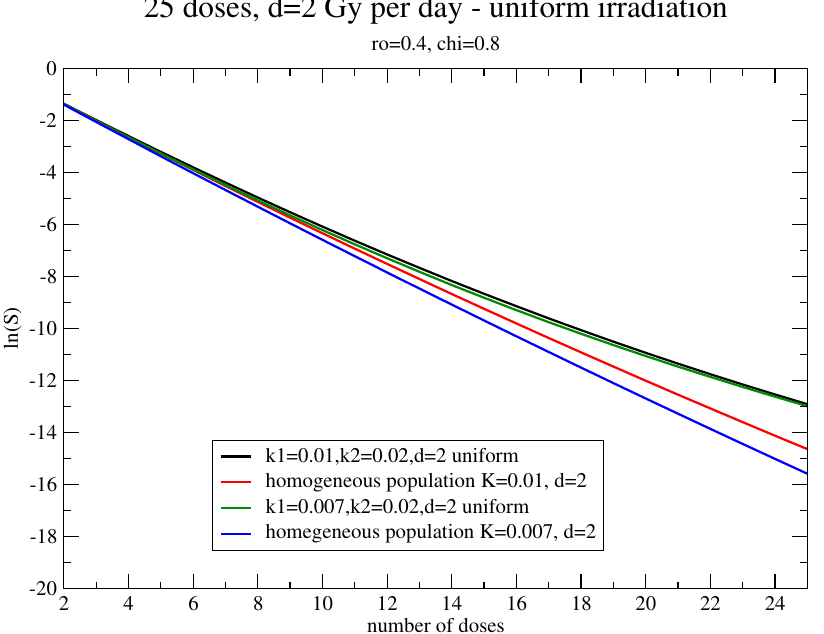
Figure 2. Estimate of the survival fraction with with two fractions, 80%/20% of N 0 and 40%/60% ( 1 ) = 0.01, k ( 2 ) = 0.02 in day ( − 1 ) , α = 0.3 Gy ( − 1 ) , β = 0.03 Gy ( − 2 ) , k g = k ( 1 ) of N ∞ , with k g g ( 1 ) = 0.007 in day ( − 1 ) is shown. k g